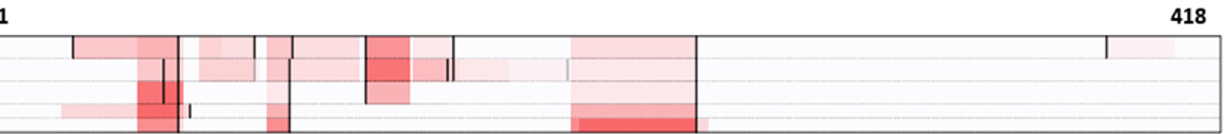
Figure 2. Detected peptides by mass spectrometry in five cases; each row of dog cases (1–3) and cat cases (1, 2) is colored from top to bottom based on the total number of peptides detected in five cases. Warmer colors indicate a higher number of peptides detected. The maximum number of detections (shown in red) was 10, 13, 14, 4, and 4, respectively. Black bars indicate non-tryptic truncation sites.